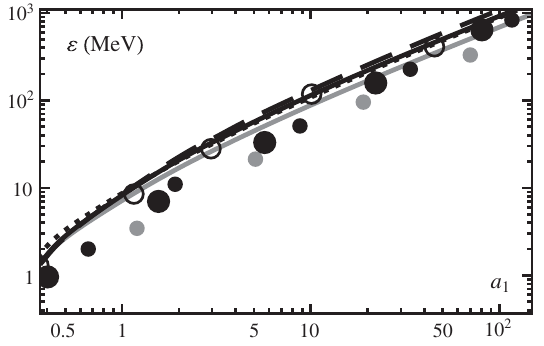
FIG. 6. Maximum proton energy vs absorbed laser field amplitude a 1 . Circles represent the numerical simulations and lines are the theoretical results for the following laser parameters: d ¼ 2 μ m, τ ¼ 30 fs (gray dots and solid gray line), d ¼ 4 μ m, τ ¼ 30 fs (small black dots and solid black line), d ¼ 6 μ m, τ ¼ 30 fs (large black dots and dashed black line), d ¼ 4 μ m, τ ¼ 150 fs (open circles and dotted black